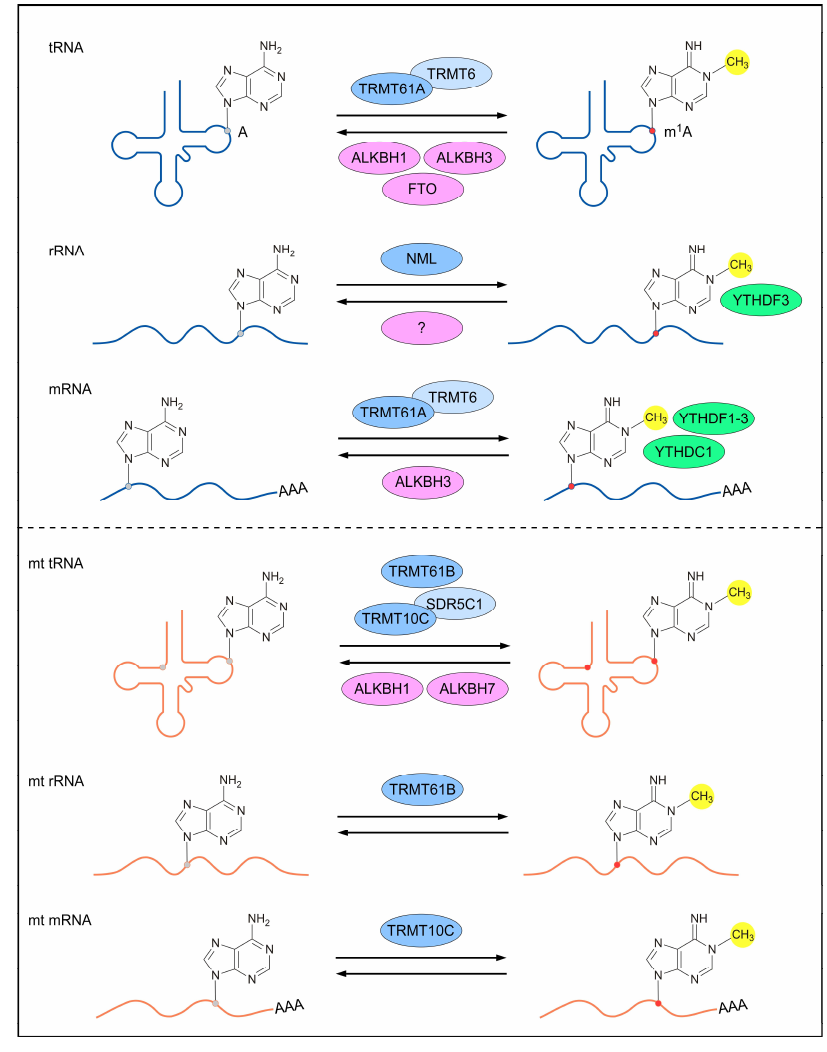
Figure 1. m 1 A-modifying proteins for different types of RNAs. The nuclear-encoded (top panel) and mitochondrial (bottom panel) RNAs are reversibly methylated by m 1 A methyltransferases (blue; dark blue represents catalytic core of the methylase complex), demethylased by m 1 A demethylases (pink), and bound by m 1 A-dependent RNA-binding proteins (green). A, adenosine; m 1 A, N 1 - methyladenosine; TRMT, tRNA (adenine (58)-N (1))-methyltransferase subunit; ALKBH, α-ketoglu- tarate-dependent dioxygenase alkB homolog; FTO, α-ketoglutarate-dependent dioxygenase alkB homolog FTO; NML, nucleomethylin; YTHDF, YTH domain-containing family protein; YTHDC1, YTH domain-containing protein 1; SDR5C1, 3-hydroxyacyl-CoA dehydrogenase type-2. 2.1. m 1 A-Modifying Proteins for Nuclear-Encoded Transcripts m 1 A is highly abundant in tRNAs, and data on the modifying proteins for m 1 A58 are clearer than those for other m 1 A sites in cytoplasmic tRNAs. The tRNA m 1 A58 methyl- transferase complex was first identified in Saccharomyces cerevisiae, which contains a non- catalytic subunit and a catalytic subunit encoded by tRNA (adenine(58)-N(1))-methyltrans- ferase non-catalytic subunit TRM6 (Trm6 ) and Trm61 , respectively [22]. Trm61 is critical for AdoMet binding and catalytic function, while Trm6 is responsible for tRNA binding [23]. The conserved homolog of this complex in eukaryotes comprises TRMT61A and TRMT6, which mediate the m 1 A58 modification in cytoplasmic tRNAs [24]. Demethylases for nu- clear-encoded tRNAs include α-ketoglutarate-dependent dioxygenase alkB homolog 1